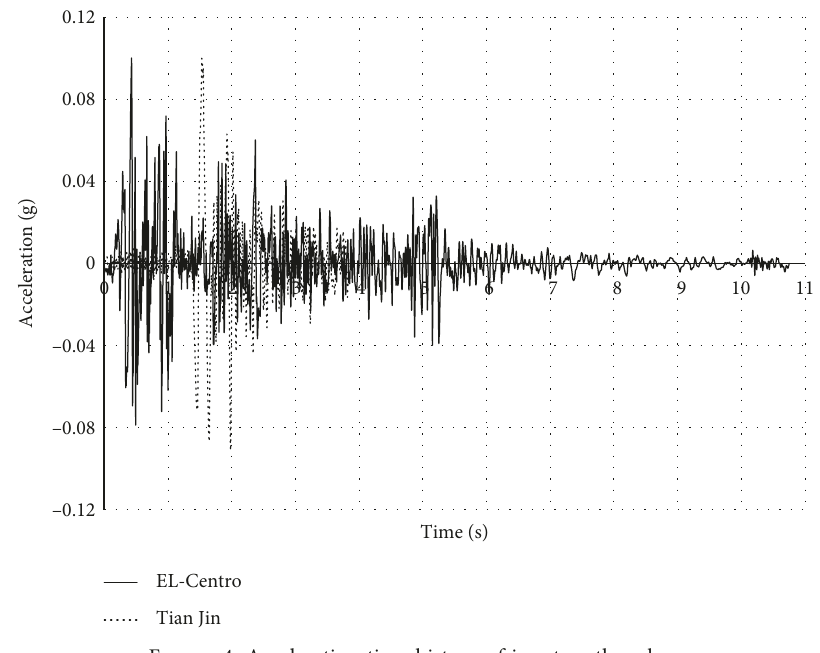
Figure 4: Acceleration time history of input earthquakes.